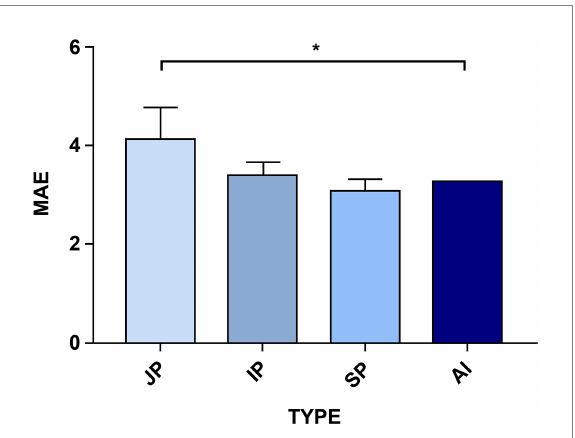
FIGURE 5 A comparison of the AI models’ and the different-level pathologists’ errors using the Mean Absolute Error (MAE) factor. The optimized YOLO v5 model’s performance was compared with that of nine pathologists with different experience levels who made the test set diagnoses. JP is the junior pathologists, IP is the intermediate pathologists, SP is the senior pathologists, and AI is the improved YOLO v5 detection. The higher the MAE factor value, the worse the error in diagnosing HPCF. The senior pathologists (SP) have the highest detection accuracy for the indices, whereas the model takes second place. Significance is indicated with p -value ≤ 0.05